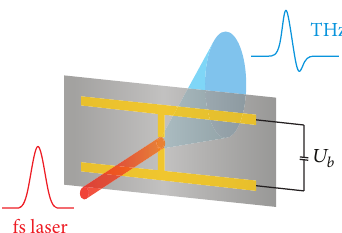
Figure 2: Schematic of a standard THz-TDS experimental setup. The optical pulse is split into two halves. The one through the beam splitter reaches the emitter antenna after a fixed flight time and gives rise to the THz pulse to be emitted into the free space and travel through THz optics to the detector. The reflected part of the optical pulse is delayed by means of the delay line before reaching the detector antenna against the arrival time of the THz pulse.Dependingonthedelaylinepositiontheopticalpulse“opens” the antenna to detect different elementary sections along the electric field amplitude envelope of THz